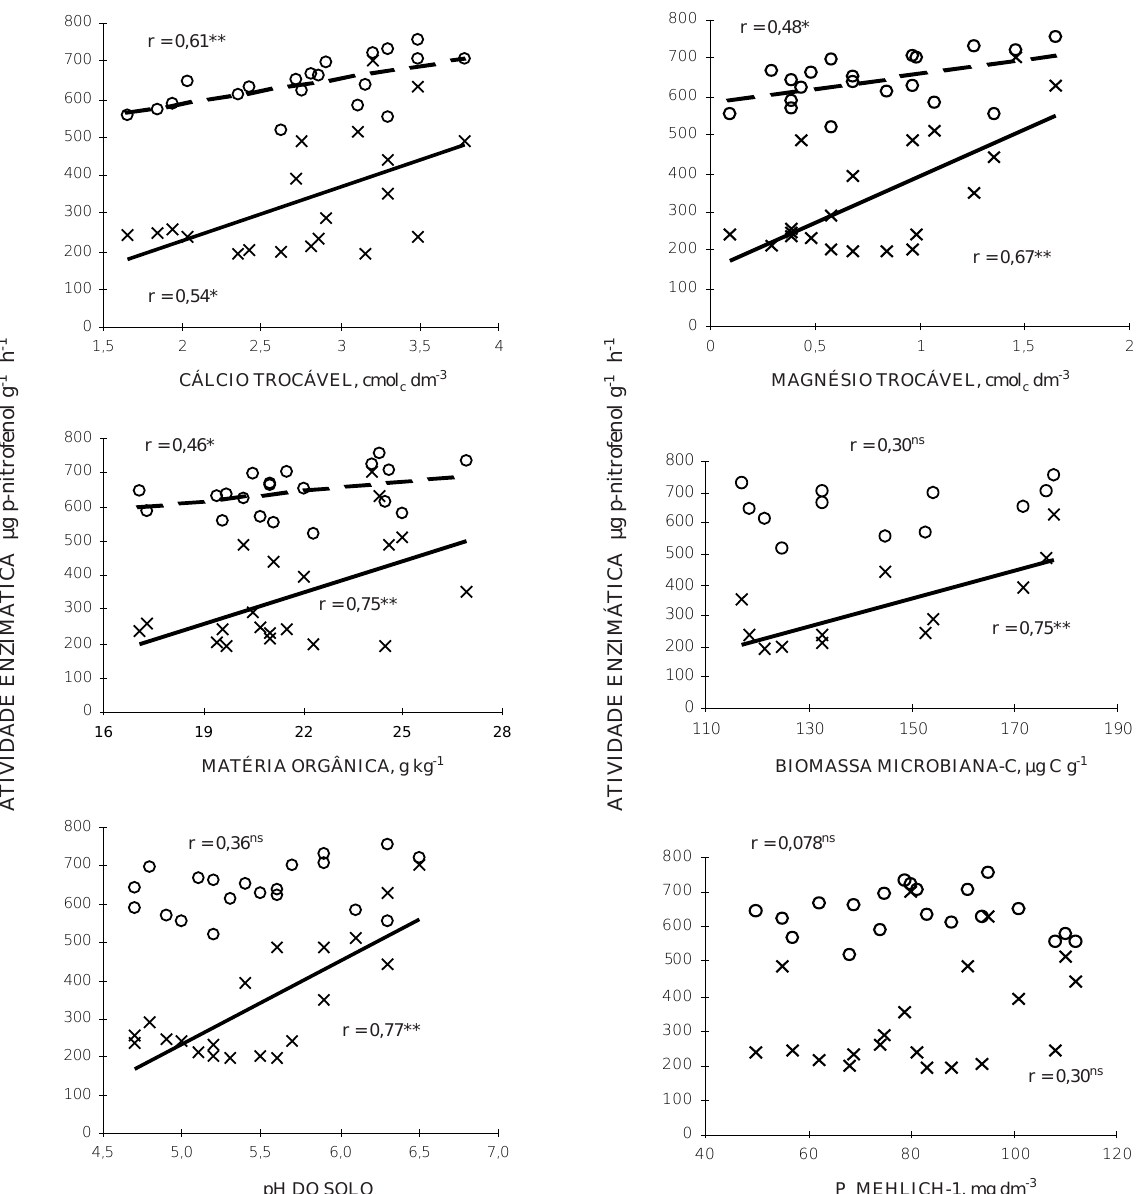
Figura 3. Correlações entre as atividades de fosfatases ácidas (--- o ---) e alcalinas ( (cid:190)(cid:190)(cid:190)(cid:190)(cid:190) x (cid:190) (cid:190) (cid:190) (cid:190) (cid:190) ) e os teores de cálcio e magnésio trocáveis, matéria orgânica, biomassa microbiana-C, pH e fósforo disponível em um solo de tabuleiro costeiro de Umbaúba